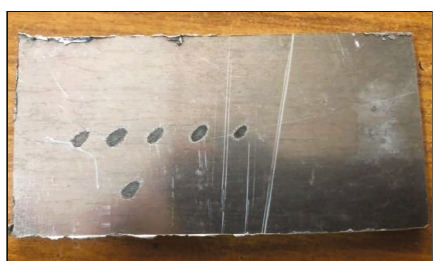
Figure 5: Machined sample of aluminium.